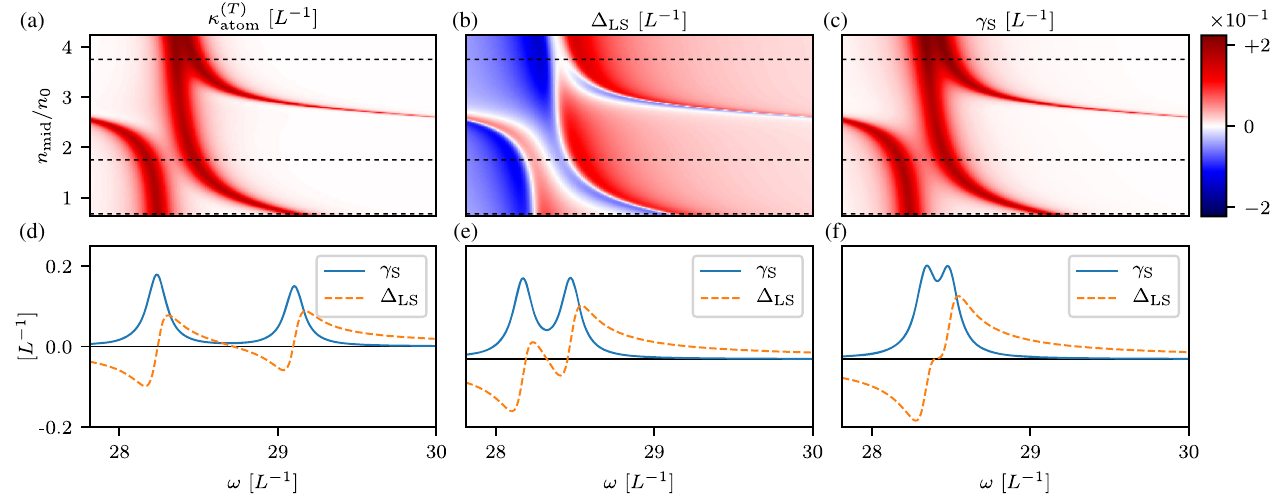
FIG. 12. Quantum optical quantities corresponding to the atom-cavity spectra in Fig. 11. The Purcell-enhanced linewidth γ of the S 2 π j½ W † ð ω Þ D − 1 ð ω Þ g (cid:3) g T D − 1 ð ω Þ W ð ω Þ(cid:2) atom and its cavity-modified Lamb shift Δ as well as κ ð T Þ 1 ; 0 j are shown. These quantities LS atom ¼ are the atomic line analogs of the empty cavity couplings shown in Fig. 6 and are computed using the ab initio few-mode theory with a 2 . 7 , 7.0, and 15.0, respectively, demonstrating the transition between different single system mode ( χ 9 ). (d) – (f) show slices at n mid ¼ regimes and that even the single-mode theory is able to include effects beyond the isolated resonance